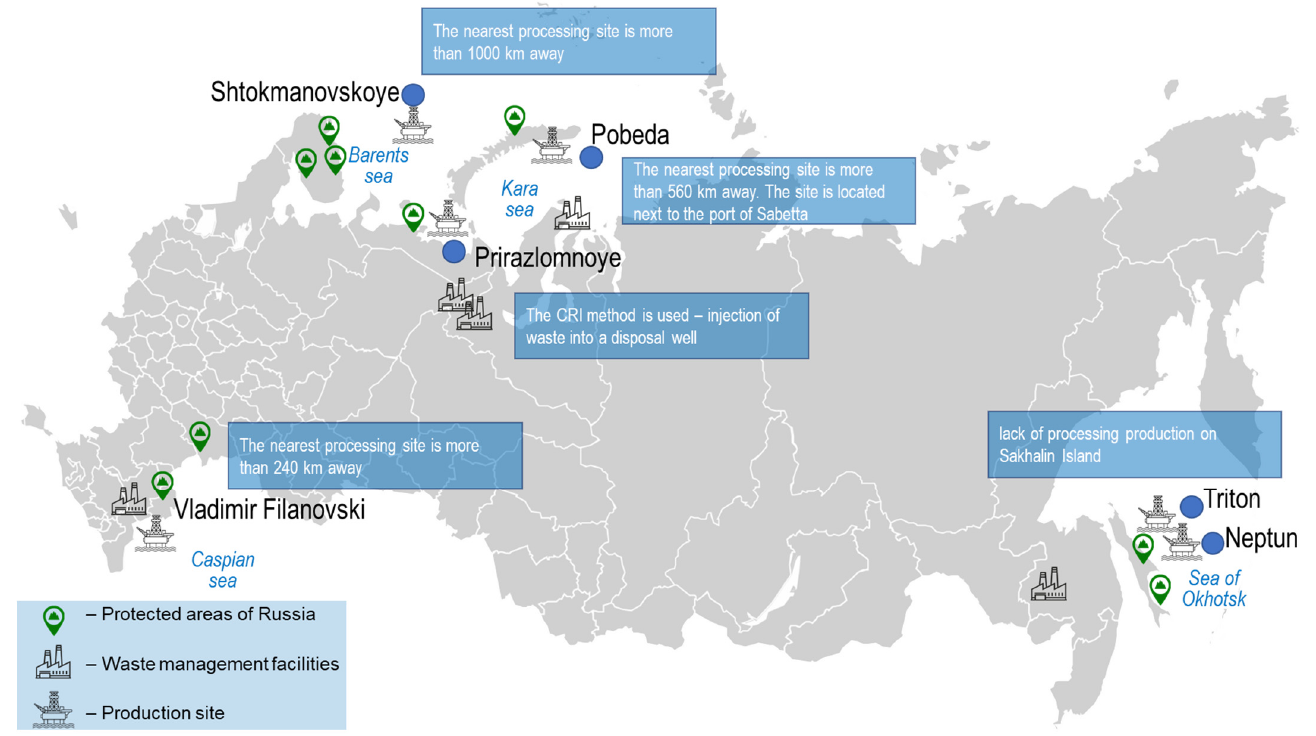
Figure 9. The availability of production facilities and the proximity of specially protected areas to some of Russia’s offshore fields. Adapted from [65].